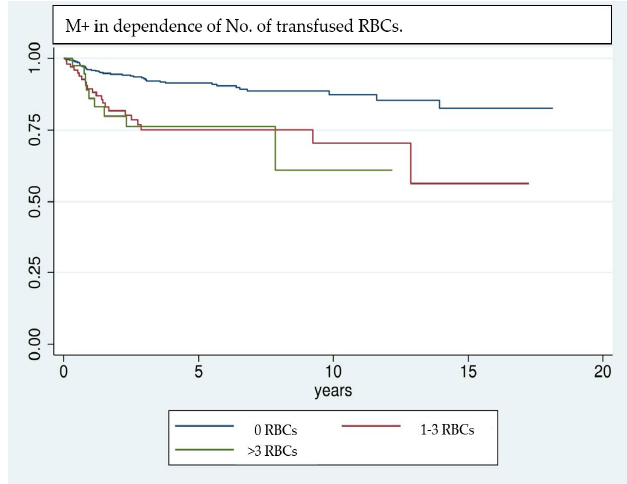
Figure 1. Kaplan–Meier analysis of the development of M+ in dependence of the number of trans- fused RBC units. Patients who did not receive RBC transfusions in the perioperative stage show a comparatively lower rate of M+. Especially in the first 3 years after surgery patients who received RBC transfusions tend to develop M+ more frequently.